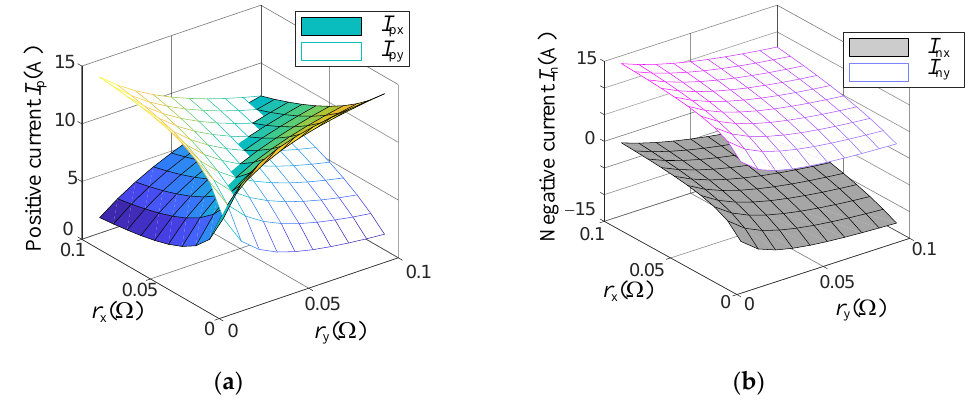
Figure 6. Influence of line resistance on ( a ) positive DC current and ( b ) negative DC current when duty cycles D 1 = D 2 = 0.5.